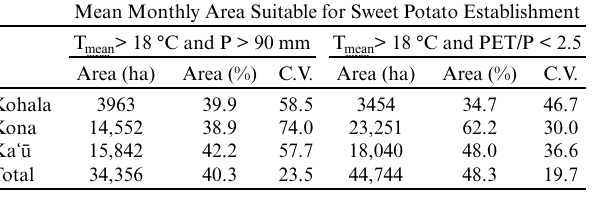
Table 1 . Monthly cultivable area summarized as mean hectares and percentage of each field system and coefficient of variation as an index of monthly variation (seasonality) over the annual cycle, expressed here as a percent. Areas were estimated on a pixel- by-pixel basis when criteria were imposed for monthly temperature and moisture conditions (rainfall, P > 90mm and aridity, PET/P < 2.5) for each field system individually and in